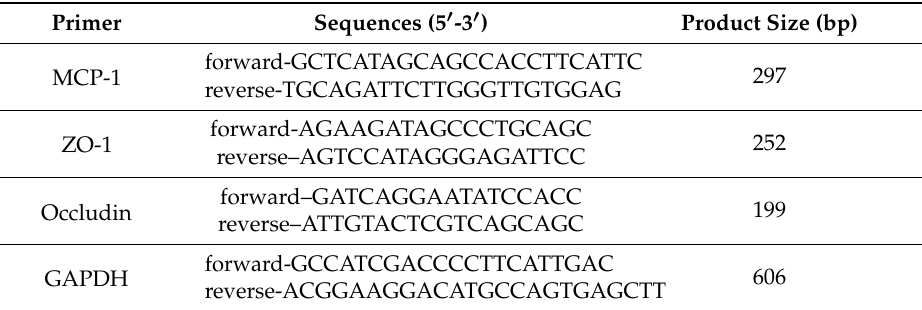
Table 1. List of primers used in